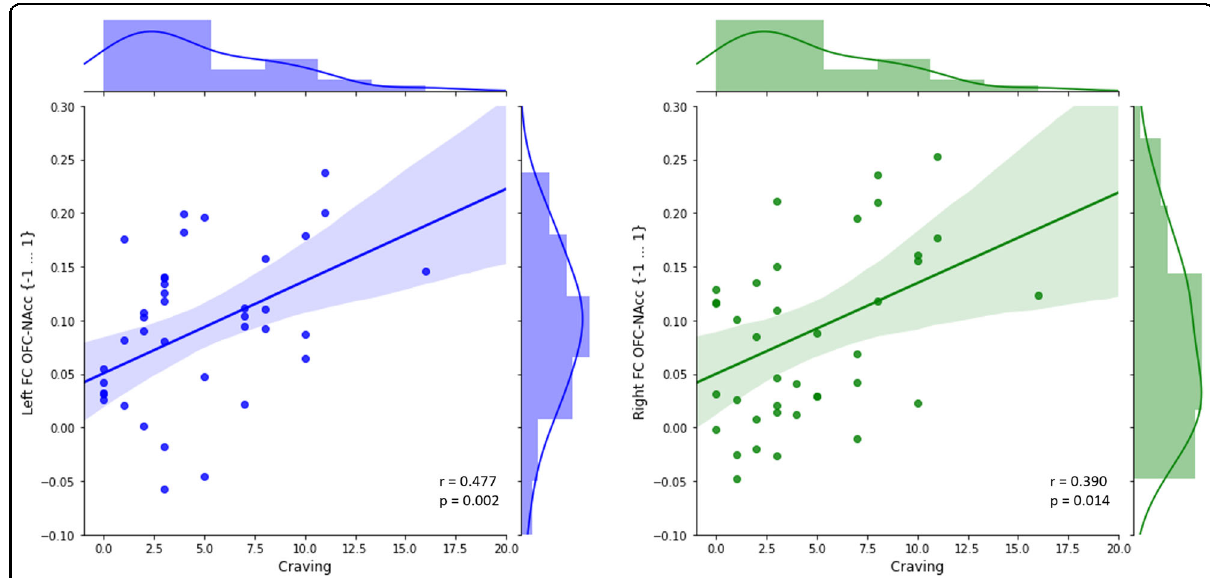
Fig. 3 Correlations of OFC-NAcc FC with craving in